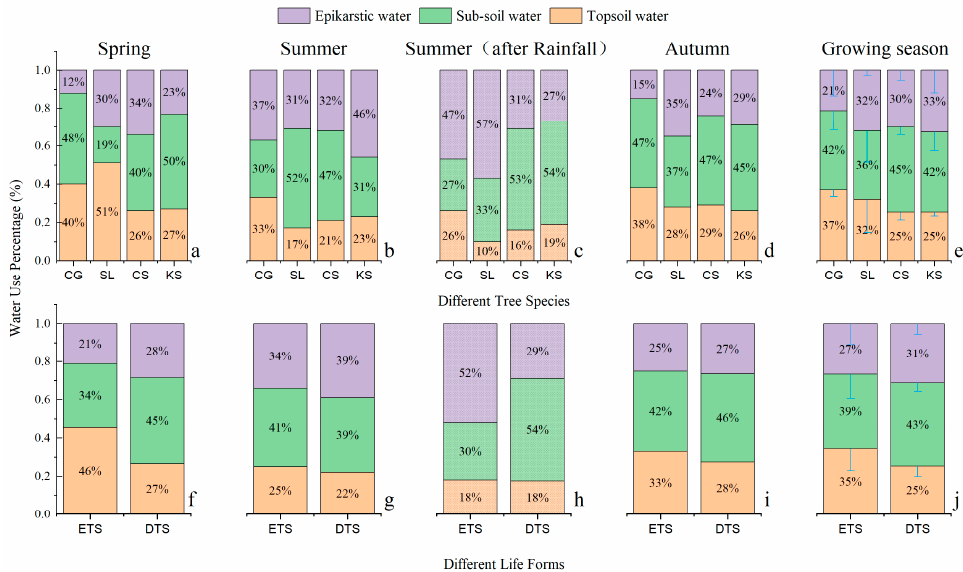
Figure 12. Plant water-use contribution from potential sources by season and before/after rainfall: ( a , f ) in Spring; ( b , g ) in Summer; ( c , h ) in Summer (after Rainfall); ( d , i ) in autumn; ( e , j ) in growing season. Blue solid line in e and j represents standard deviation.